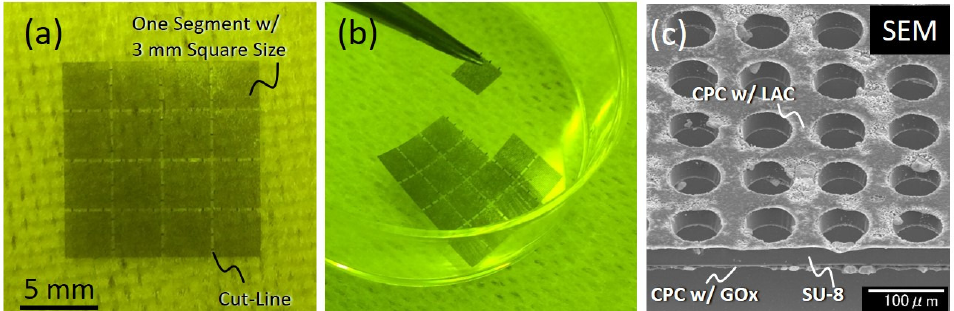
Figure 5. Fabricated prototypes of the film-shaped micropump array. ( a ) Overview of 4 × 4 segments with 3 mm square size. ( b ) One scene where a segment is separated along a cut line like a postage stamp. ( c ) Scanning electron microscope (SEM) image of the area around the through-hole